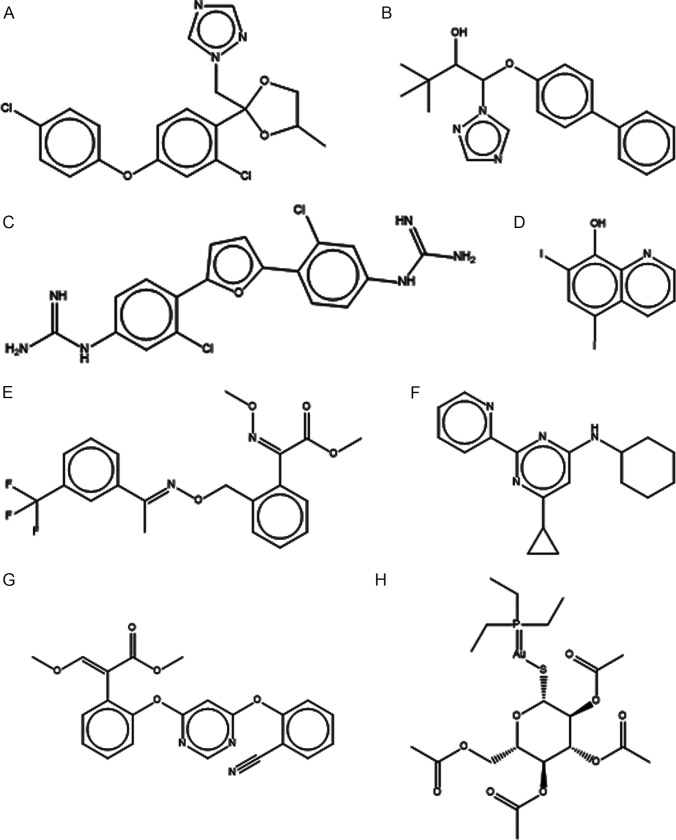
Chemical structures of the eight compounds with anti-Fonsecaea pedrosoi activity present in the MMV Pathogen Box® collection: (A) MMV688943 (difenoconazole); (B) MMV688942 (bitertanol); (C) MMV688179 (2-[3-chloro-4-[5-[2-chloro-4-(diaminomethylideneamino)phenyl]furan-2-yl]phenyl]guanidine); (D) MMV002817 (iodoquinol); (E) MMV688754 (trifloxystrobin); (F) MMV021013 (N-cyclohexyl-6-cyclopropyl-2-pyridin-2-ylpyrimidin-4-amine); (G) MMV021057 (azoxystrobin); (H) MMV688978 (auranofin).